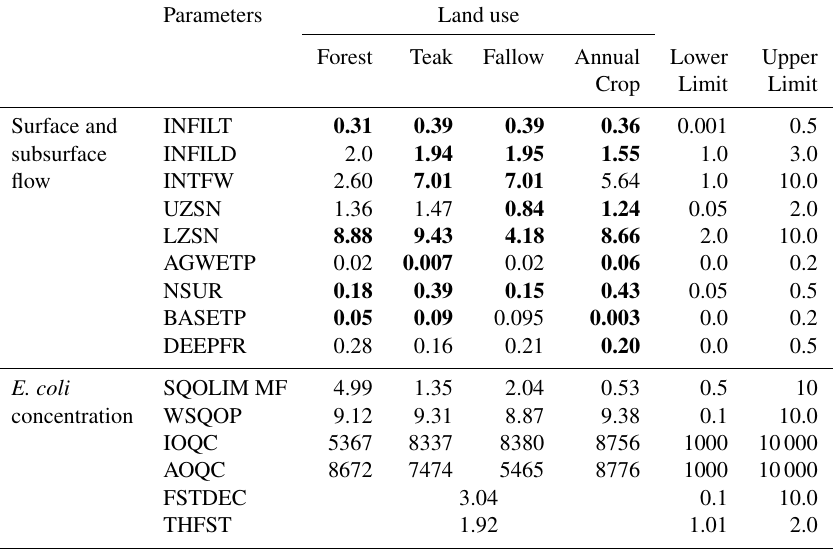
Table 1. Optimal values and range of HSPF parameters for surface and subsurface flows and E. coli concentration. Bold parameters were optimized during the flow calibration process. All parameters related to E. coli were optimized during model calibration.